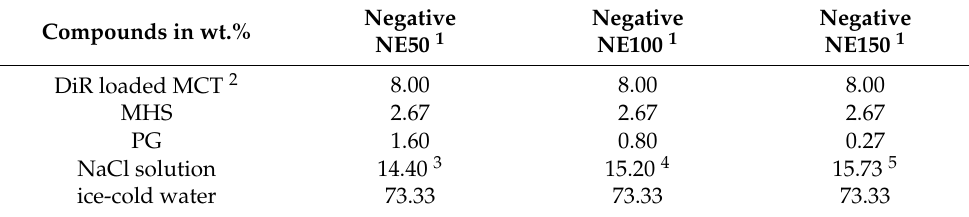
Table 1. Composition of the isotonic, negatively surface-charged nanoemulsions for the animal trials. Compounds in